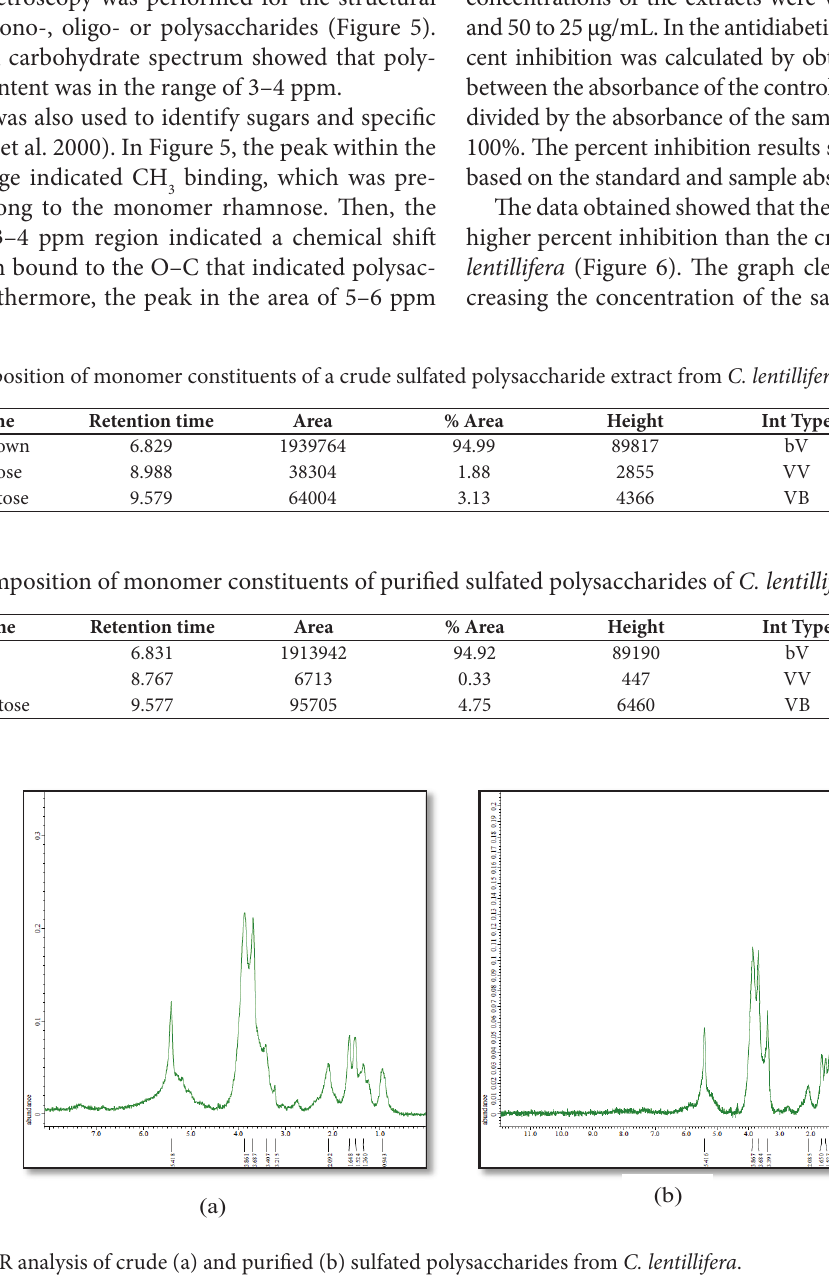
Figure 5. NMR analysis of crude (a) and purified (b) sulfated polysaccharides from C. lentillifera .